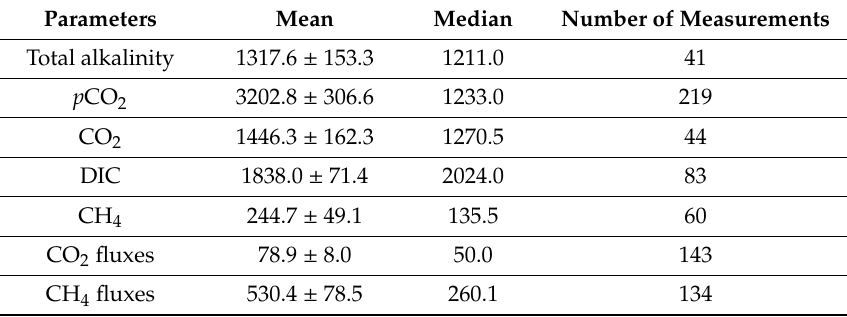
Table 1. Mean ( ± 1SE) and median concentrations of alkalinity ( µ M), p CO 2 ( µ atm), CO 2 ( µ M), dissolved inorganic carbon (DIC, µ M), and CH 4 (nM) and CO 2 (mmol m 2 d − 1 ) and CH 4 fluxes ( µ mol m − 2 d − 1 ) across the water-air interface in mangrove waters worldwide. Data from [66–93]. Parameters Mean Median Number of Measurements